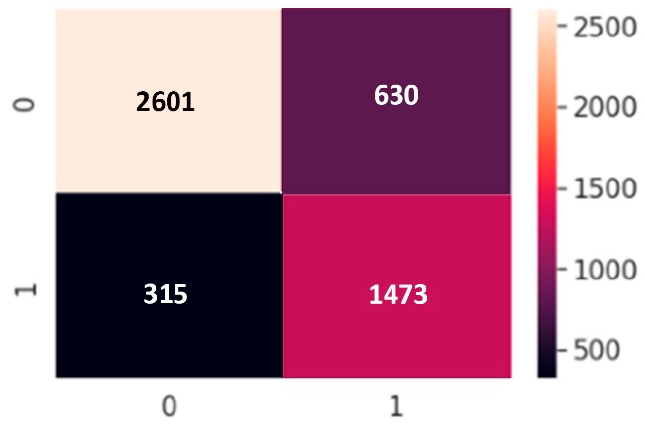
Figure 13. Confusion matrix of LSTM model.